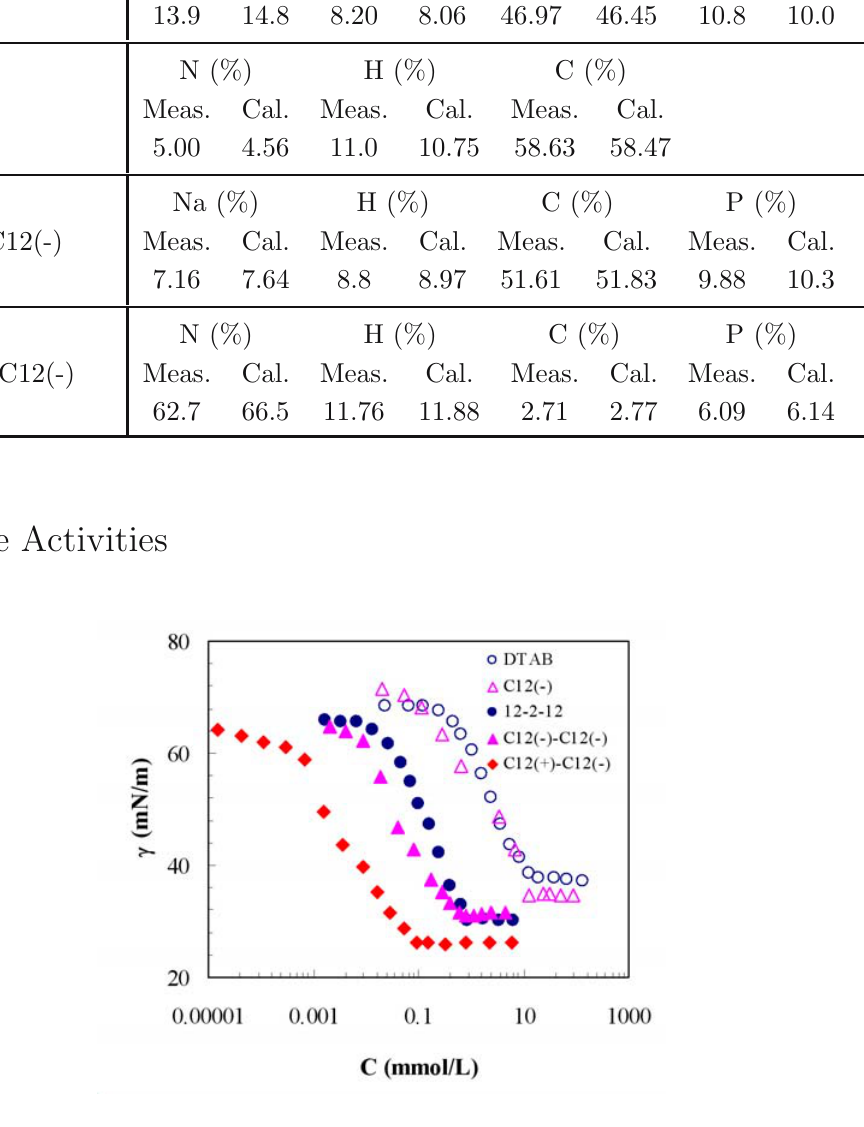
Fig. 1 Surface tension-concentration relationship of